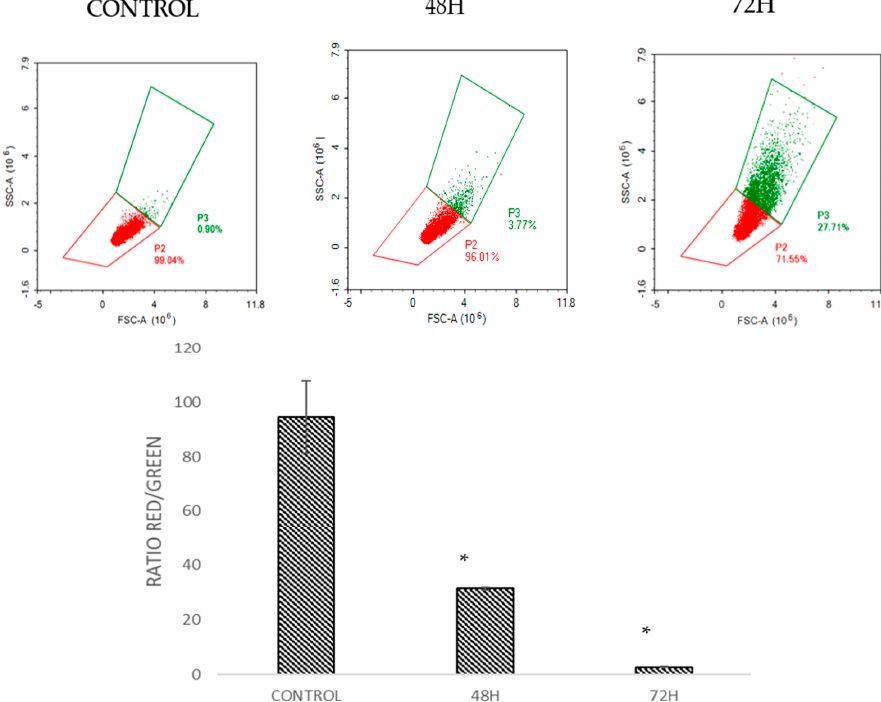
Figure 6. Histogram and quantification analysis of the depolarization of mitochondrial membrane potential for HT29 after being treated with DMCH for 48 h and 72 h. All data are expressed as mean ± standard error mean (S.E.M.). * p < 0.05 compared with corresponding controls.